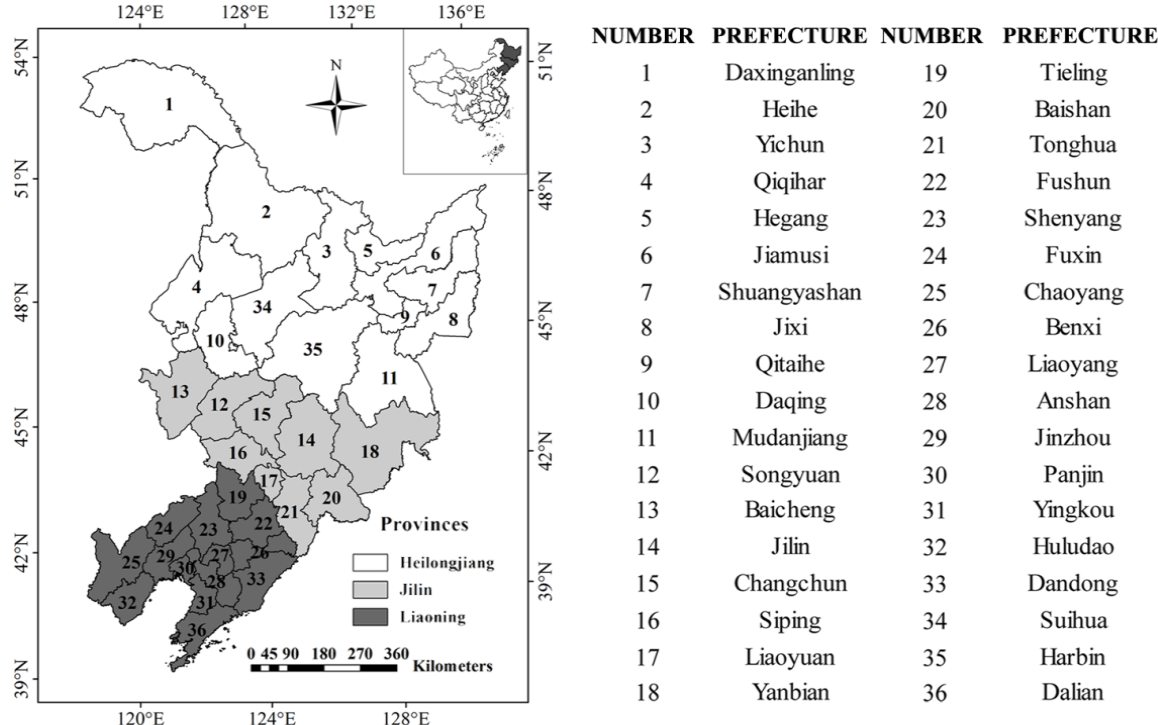
Figure 1. Location of Northeast China and the names of its 36 prefectures in three